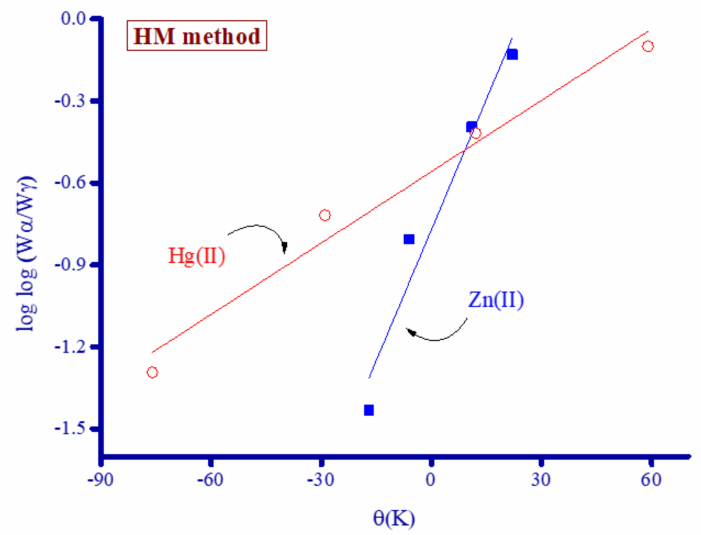
Figure 13. Thermodynamic graphs of Zn 2+ and Hg 2+ complexes derived using the HM method. The thermodynamic constants ∆ G * , E * , ∆ S * , and ∆ H * were calculated for the Zn 2+ and Hg 2+ complexes using the CR and HM equations (Table 1). The value of E * was derived from the slopes of the lines generated using Equations (1) and (2) for the CR and HM methods, respectively.